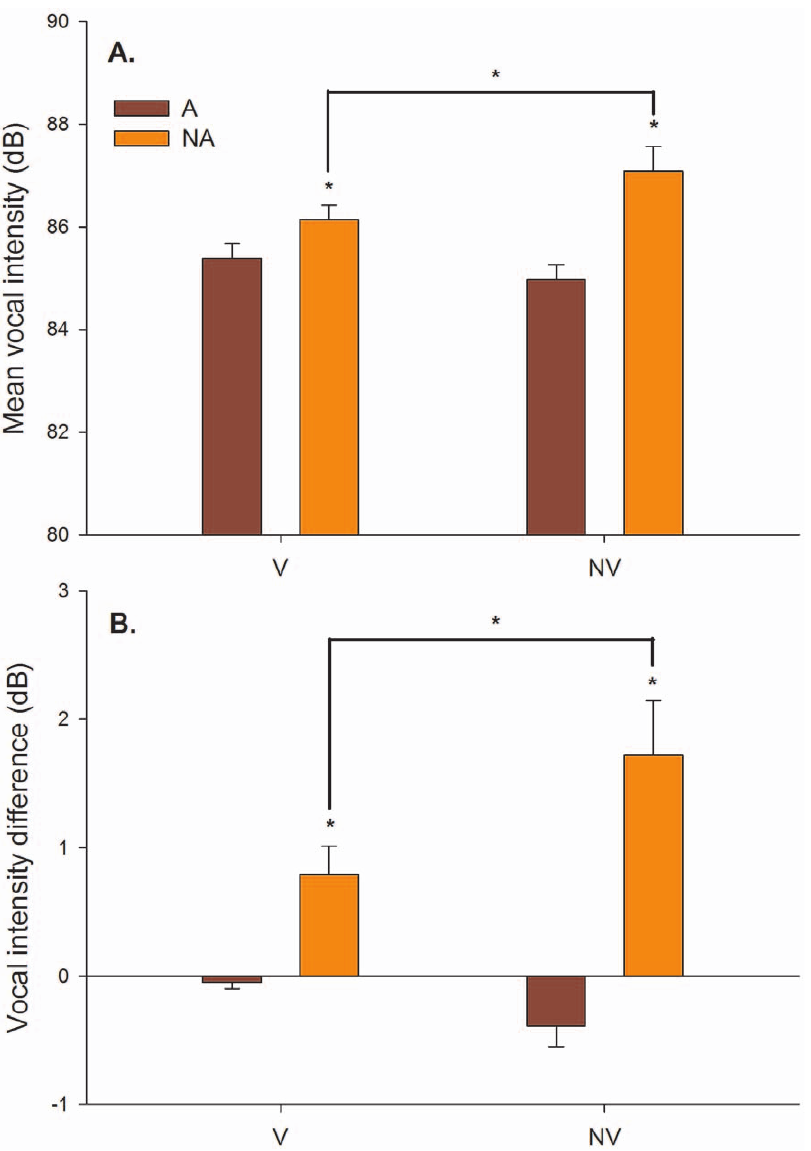
Figure 3. Significant interactions for overall vocal intensity (A) and for the difference in mean vocal intensity over the two trial phases corresponding to the period before feedback removal (t=2–10 s) and the period following it (t=11–18 s) (B) among factors of auditory feedback condition and visual feedback condition. In all cases, asterisks and connecting lines represent reliable pairwise comparisons, significant at p , .01. Error bars represent standard